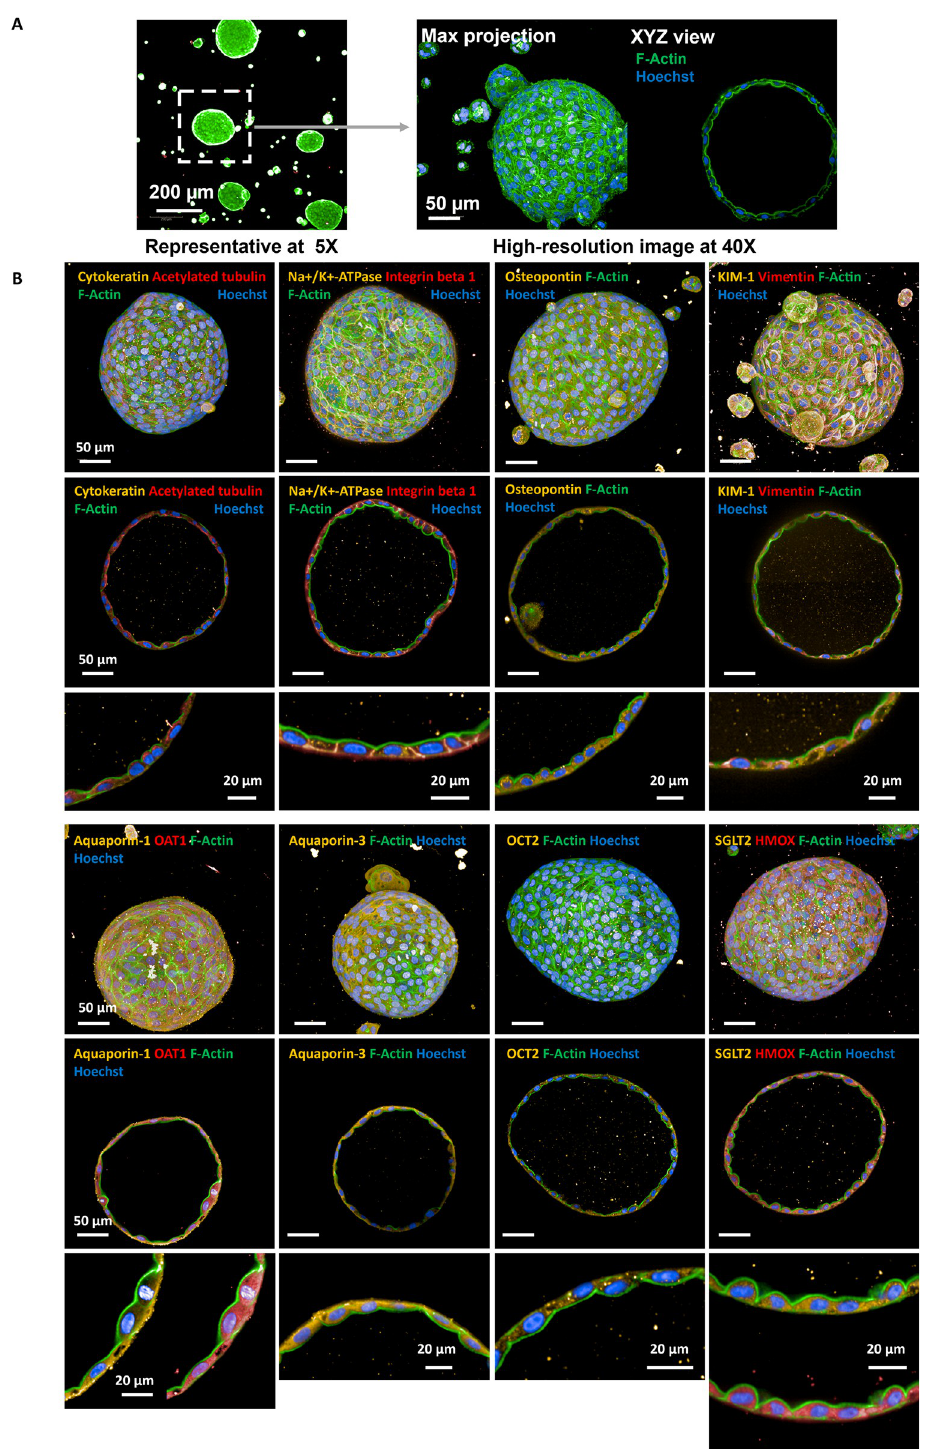
Fig 1. High throughput, high content imaging of tubuloids. (A) Tubuloids cultured in 384-well plates were imaged via Preciscan algorithm (Opera Phenix, Perkin Elmer), wherein individual tubuloids of predetermined diameter, morphology, and quantity per-well were identified and captured in high resolution. (B) Tubuloids display several key biomarkers for proximal tubules including KIM-1, Aquaporin-1, Aquaporin-3, OCT2, OAT1, SGLT2, Na+/K +-ATPase, Integrin beta 1, Acetylated tubulin, Vimentin, Cytokeratin, Osteopontin and HMOX1, and exhibit hollow